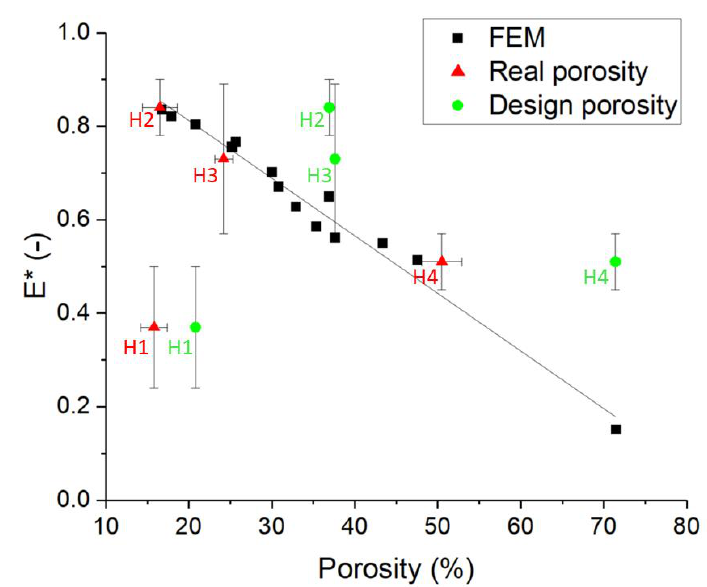
Figure 9. Comparison of the relative Young’s modulus of the 3D printed cookie honeycomb structures obtained from experimental tests and from FEM. Experimental results are reported as function of the design porosity (green circles) and of the measured porosity (red triangles).